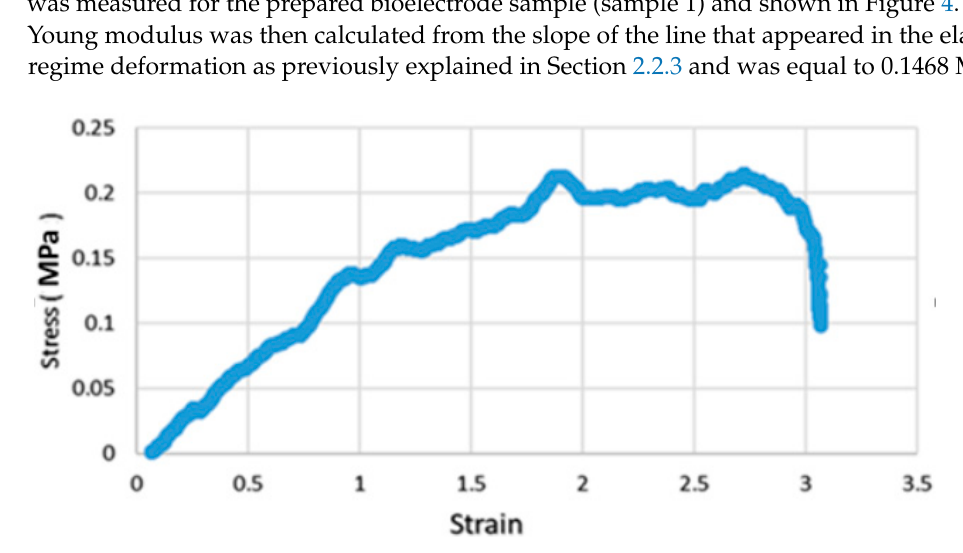
Figure 4. Stress vs. strain of the material for the sample 1. (Stress in MPa, strain in mm/mm).